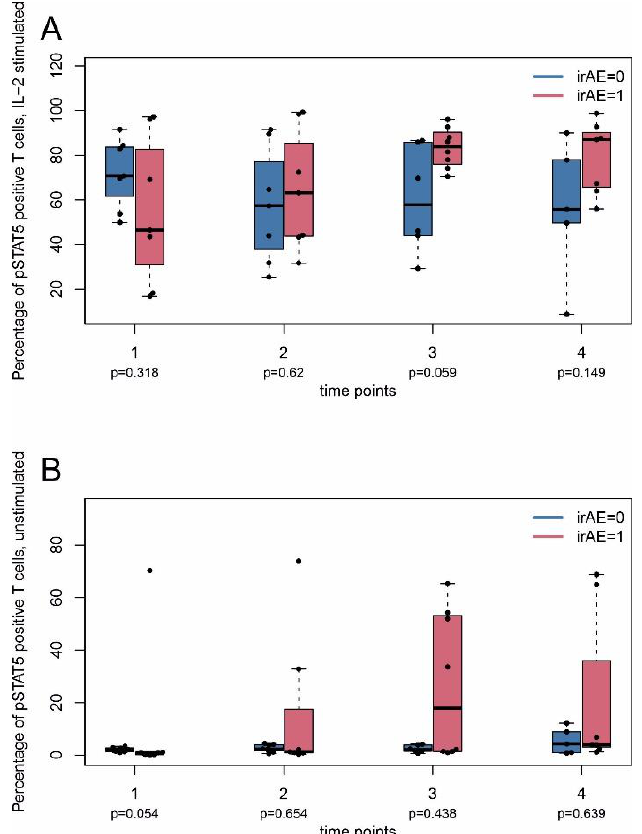
Figure 5. Intracellular expression of phosphorylated STAT5 (pSTAT5) in T cells. PBMC were taken from patients at indicated time points as described in Figure 1 and analyzed by flow cytometry (FACS). ( A ) pSTAT5 expression after T cell stimulation with IL-2 for 15 minutes. ( B ) pSTAT5 expression without T cell stimulation. irAE, immune-related adverse events. 0, without; 1, with adverse events. Nominal (unadjusted) p -values (Mann–Whitney U test between irAE = 1 and irAE = 0) are shown without adjustment for multiple testing. Data in ( A , B ) are given as percentage of pSTAT5 positive cells of total CD3 + T cells.